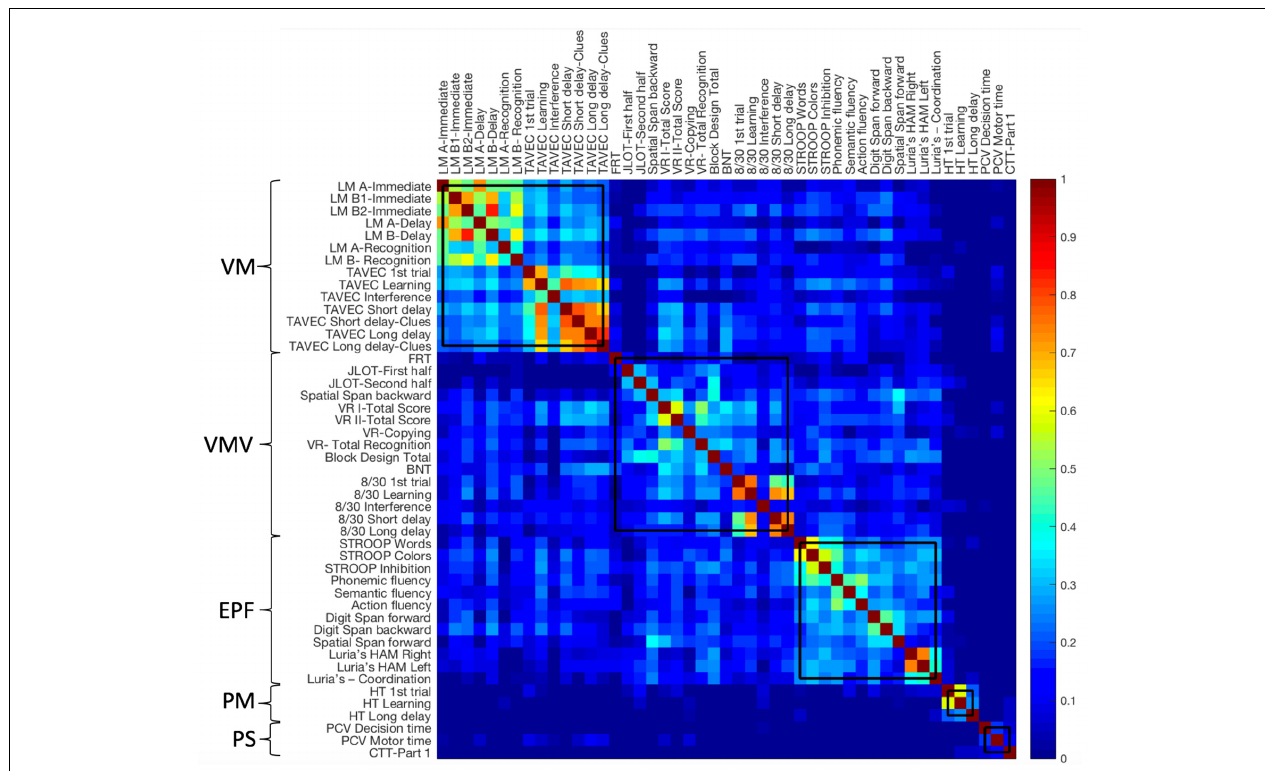
FIGURE 4 | Age-independent cognitive connectome in the whole cohort. Weighted correlation matrix in the whole cohort ( N = 334) sorted out by cognitive modules obtained with the Newman algorithm. Pearson’s correlation coefficients were used to build the matrix. The color bar indicates the strength of the Pearson’s correlation coefficients: colder colors represent weaker correlations, while warmer colors represent stronger correlations. PM, procedural Memory module; VM, verbal memory module; PS, processing speed module; VMV, visual memory and visuospatial abilities module; EPF, executive functions and premotor functions module; LM, logical memory; FRT, facial recognition test; JLOT, judgment of line orientation test; VR, visual reproduction; BNT, boston naming test; HT, hanoi tower; PCV, PC-Vienna System; CTT, color trails